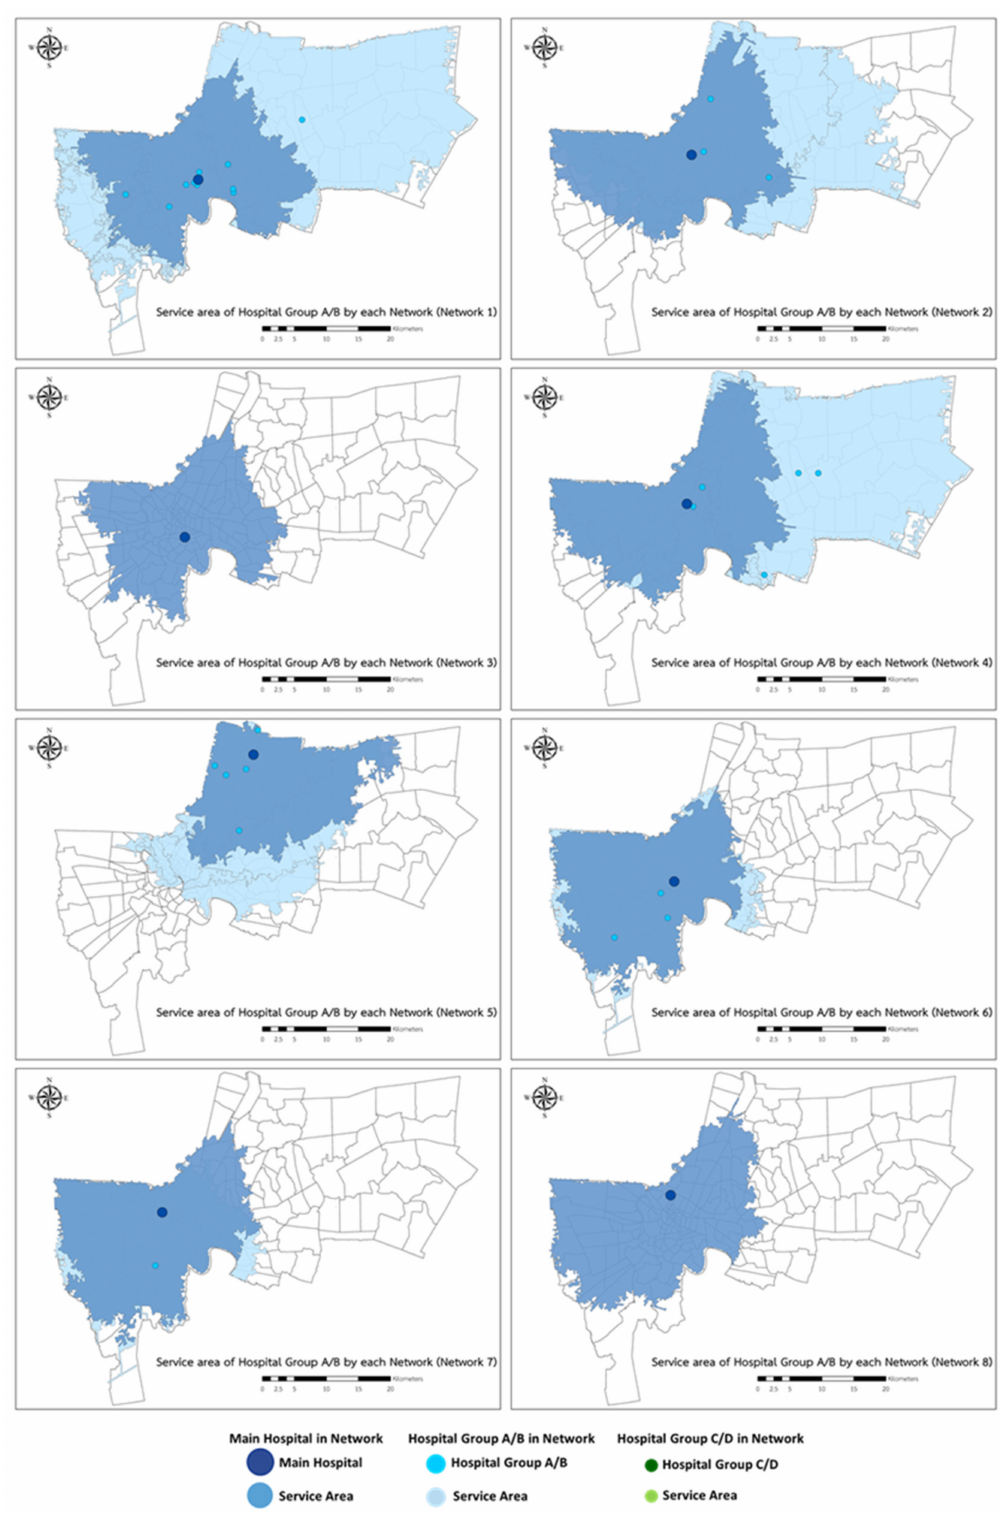
Figure 12. Service areas of Group A/B hospitals by